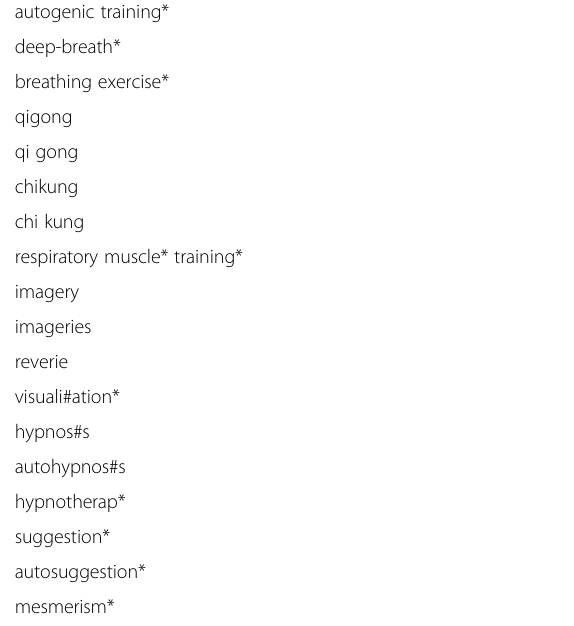
Table 1 Ovid MEDLINE®, In-Process & Other Non-Indexed Citations and OvidMEDLINE(R) 1946 to Present, search strategy